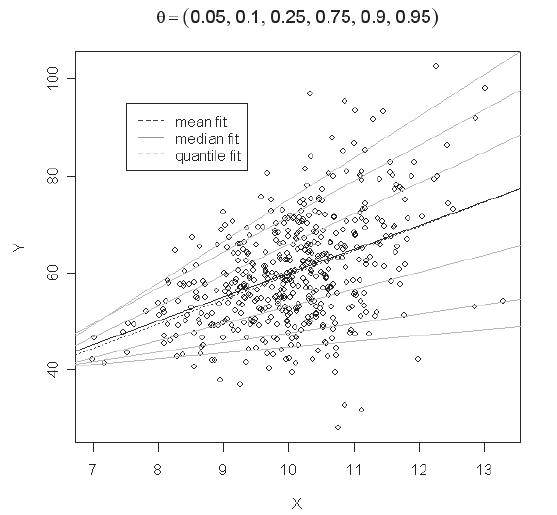
Figure 2 – QR estimates for an heterogeneous error